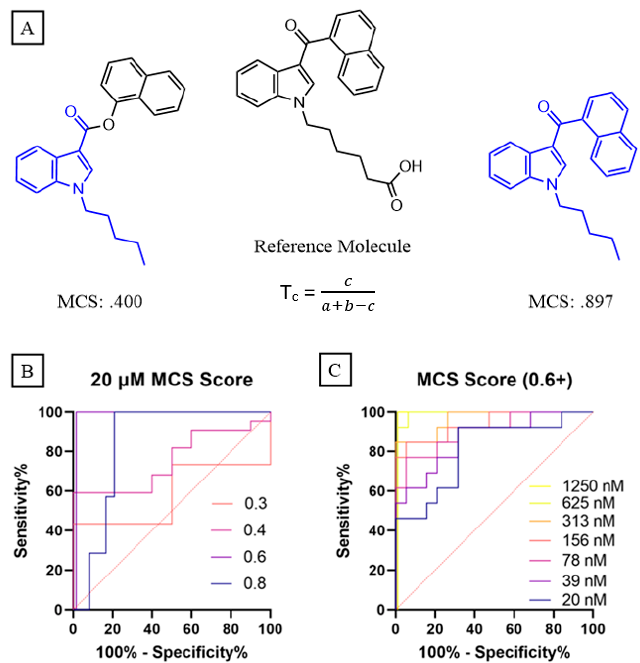
Figure 3. ( A ) Maximum common substructure (MCS) Tanimoto coefficients calculated for two structurally similar SCRAs to hapten 1 (reference molecule), where c equals the number of common non-hydrogen atoms between the molecules, and a and b equal the total number of non-hydrogen atoms for either compound. ( B ) Receiver operating characteristic (ROC) analysis at 20 µ M dilutions, showing perfect discrimination (AUC = 1) for SCRA-hapten pairs with an MCS Tanimoto coefficient of 0.6 or greater. ( C ) ROC analysis for all competitive ELISA dilutions based on the 0.6 MCS threshold determined in 3b.